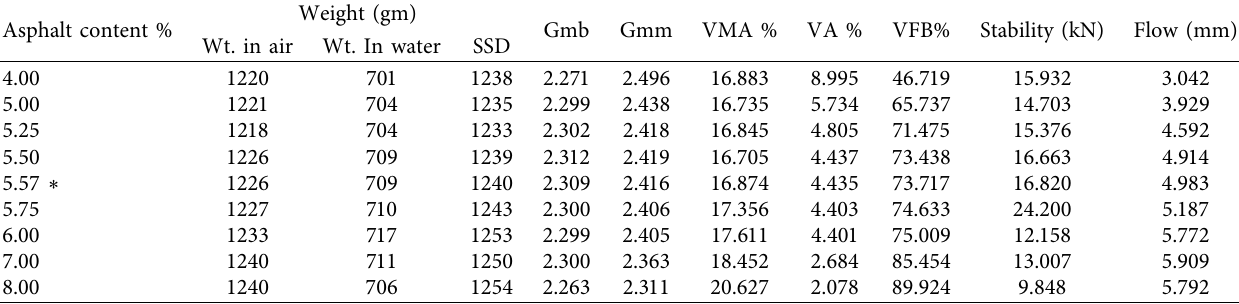
Table 10: Volumetric parameters of the AC mix with 6.5% CSD filler.